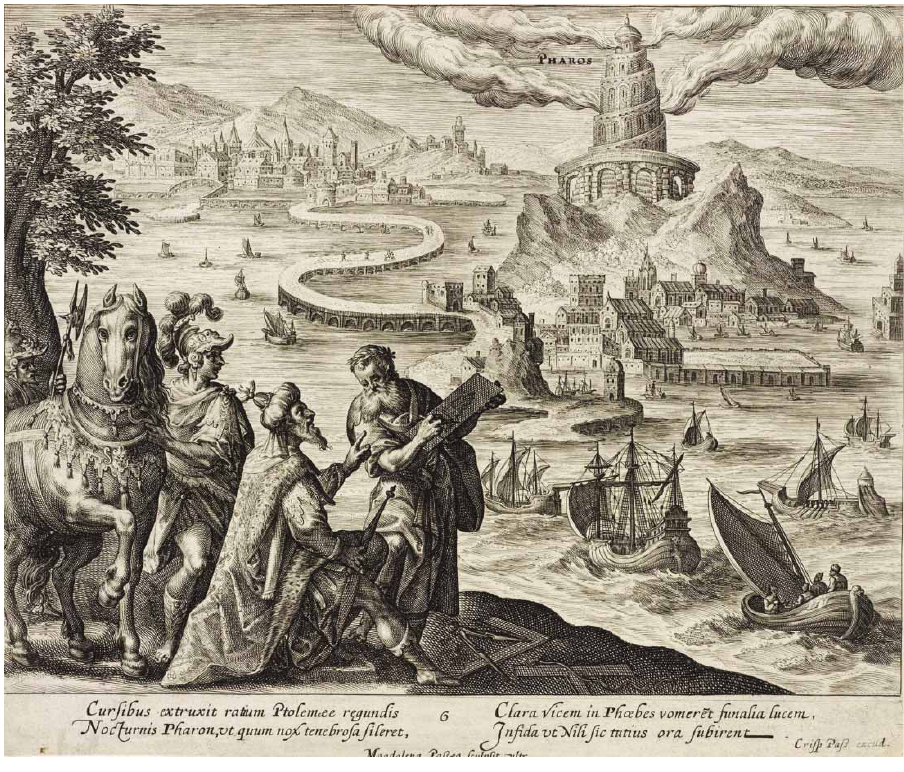
Fig. 1. Pic. of Alexandria lighthouse by Magdalena van de